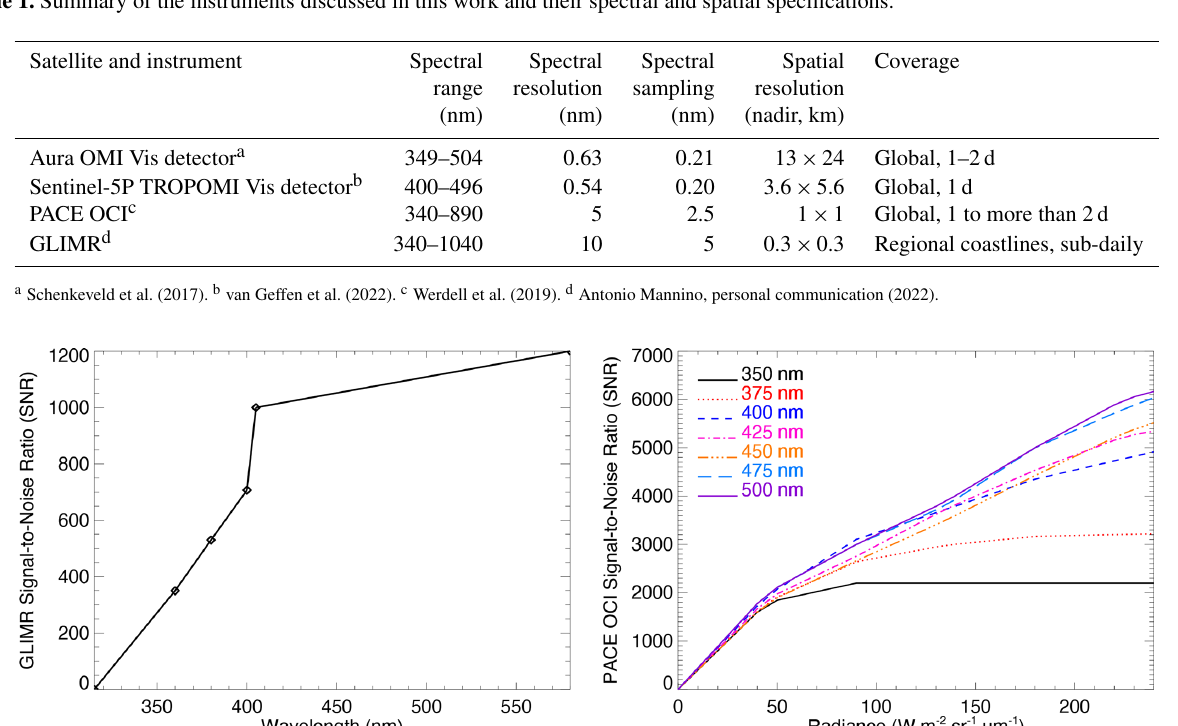
Table 1. Summary of the instruments discussed in this work and their spectral and spatial specifications.